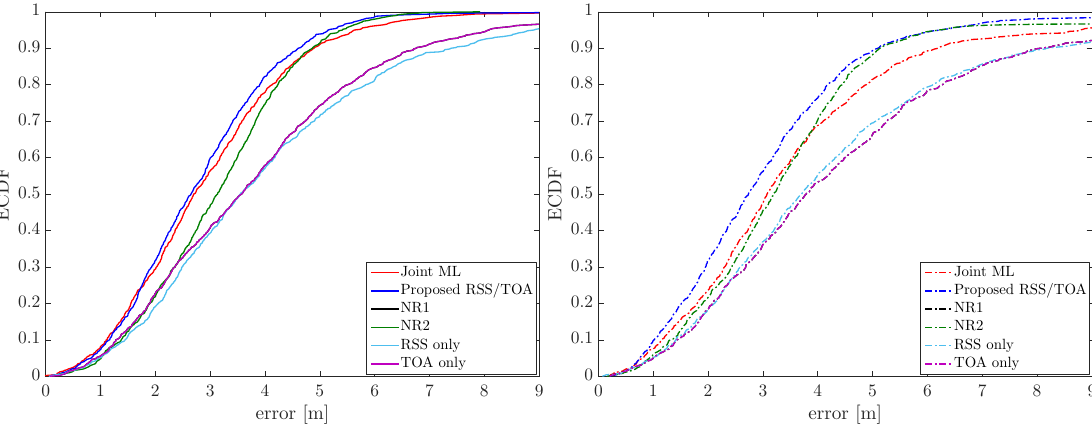
Figure 10. ECDF of the considered algorithms for the case α = 2, σ = 6 and N = 8. ( left ) Ideal TOA/RSS parameters and ( right ) estimated TOA/RSS